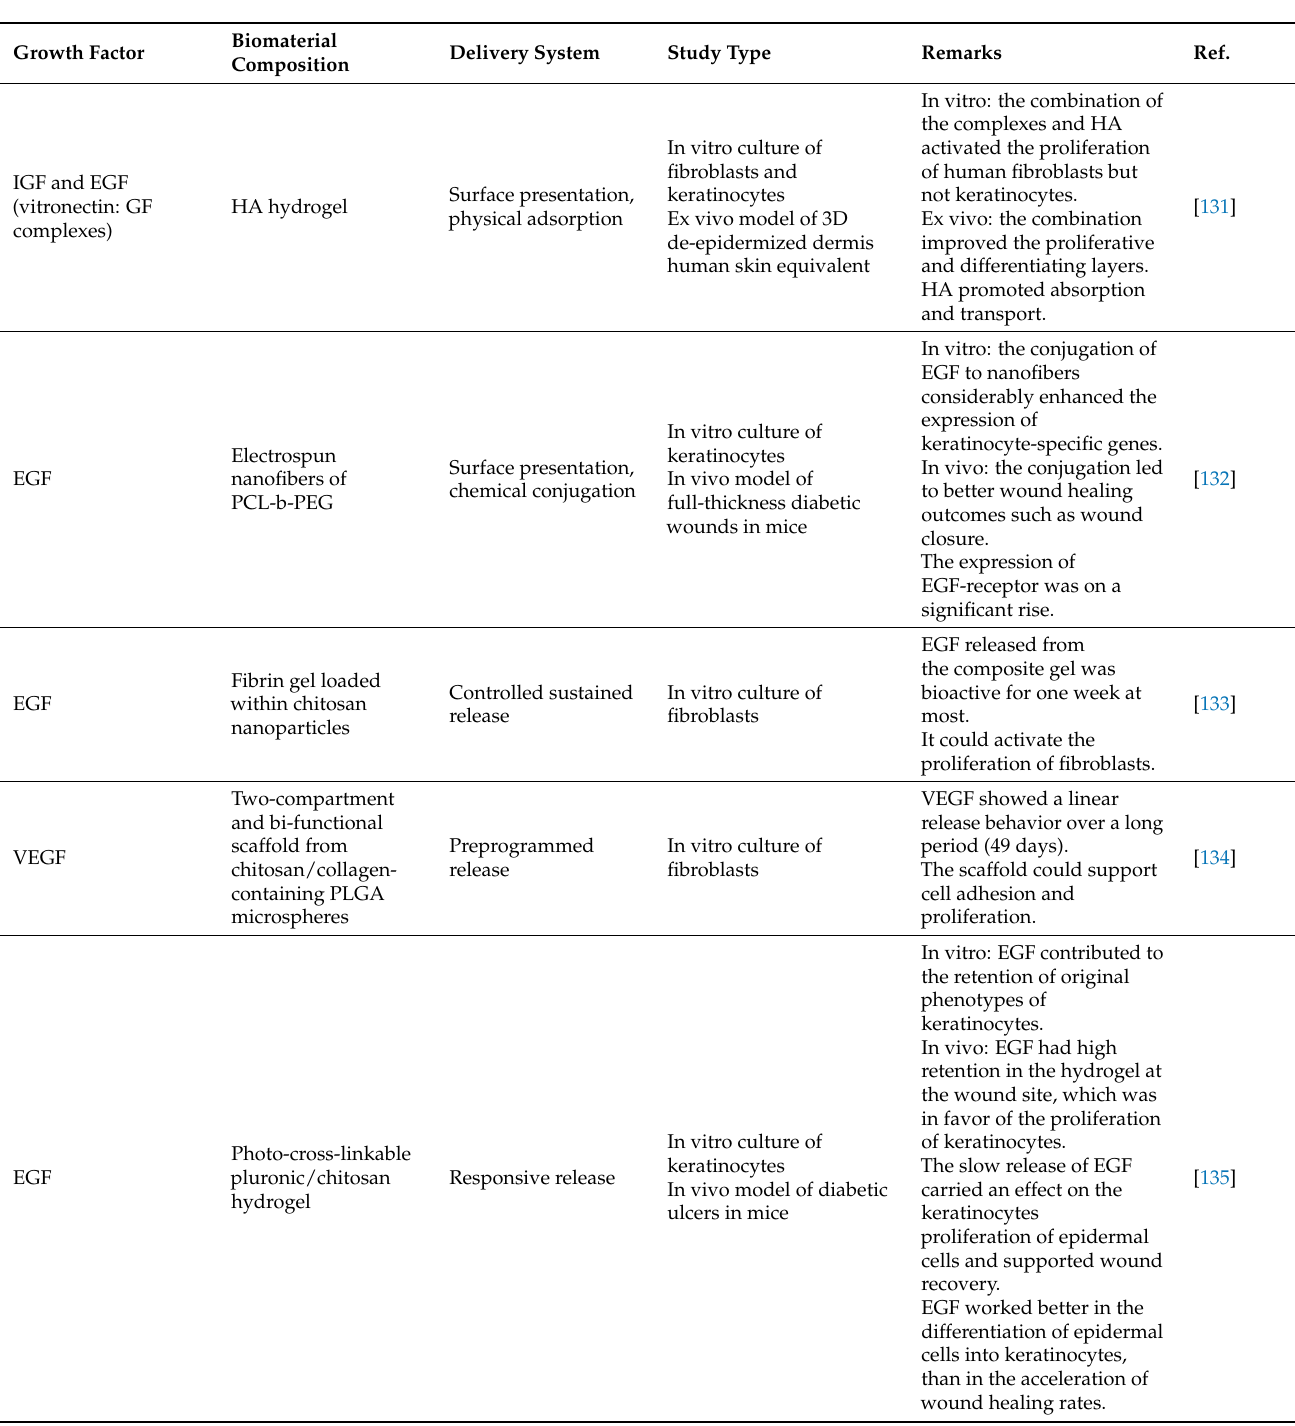
Table 3. The incorporation of GFs into matrices for skin wound applications. Abbreviations: 3D: three-dimensional, EGF: epithelial growth factor, HA: hyaluronic acid, IGF: insulin growth factor, PCL-b-PEG: poly( ε -caprolactone)-block-poly(ethylene glycol), PELA: poly( DL -lactide)-poly(ethylene glycol), PLGA: poly(lactic-co-glycolic), VEGF: vascular endothelial growth